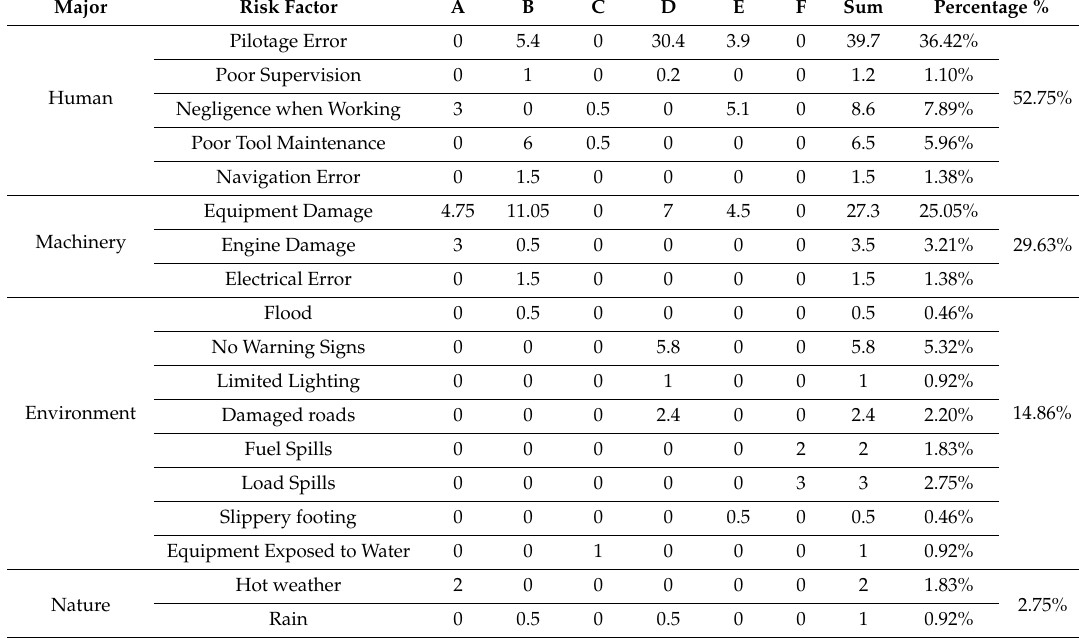
Table 3. Common causes of accidents and the percentage of their contribution.